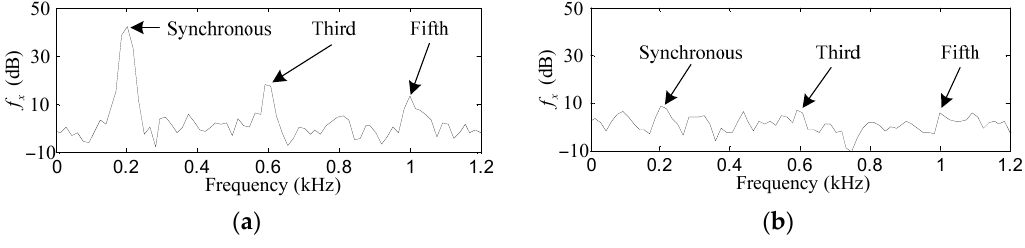
Figure 8. Simulation results of f x . ( a ) before harmonic force elimination; ( b ) after harmonic force elimination.